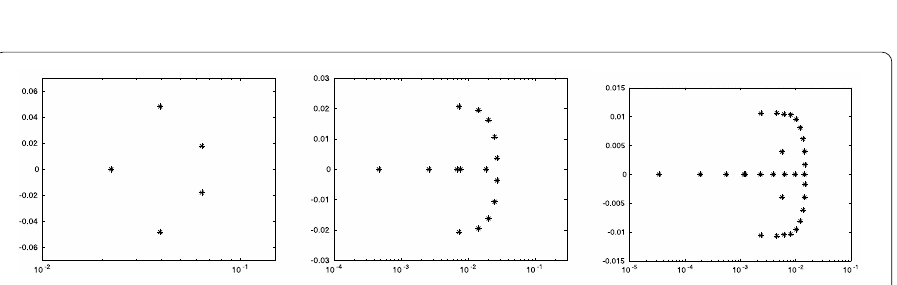
Figure 8 Eigenvalues of U n in the case of an algebraic/logarithmic weight function with parameter α = –1/2 for n = 5,15,30 (from left to right)